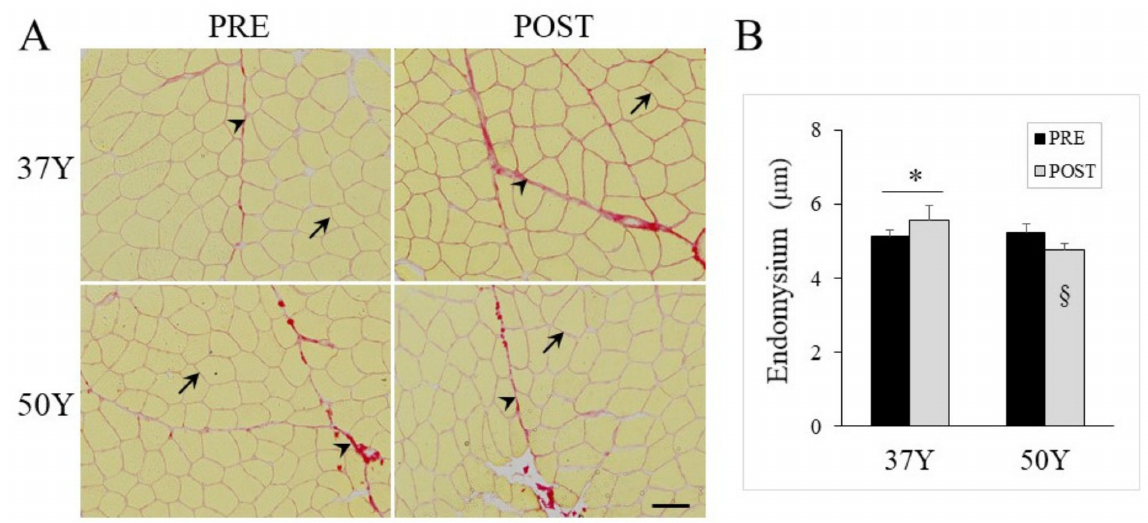
Figure 3. Muscle extracellular matrix (ECM) endomysium. ( A ) Representative images of cross- sections stained with Sirius red indicating endomysium (arrow) and perimysium (arrowhead) for middle-aged (37Y) and master (50Y) runners PRE- and POST-24TR; the scale bar represents 50 µ m. ( B ) ECM endomysium mean thickness for 37Y and 50Y runners PRE (black bars) and POST (gray bars) 24TR.). Statistical interaction was p = 0.031 between time and group. § p < 0.05 between type-I and type-IIA fibers; * p < 0.05 between PRE and POST